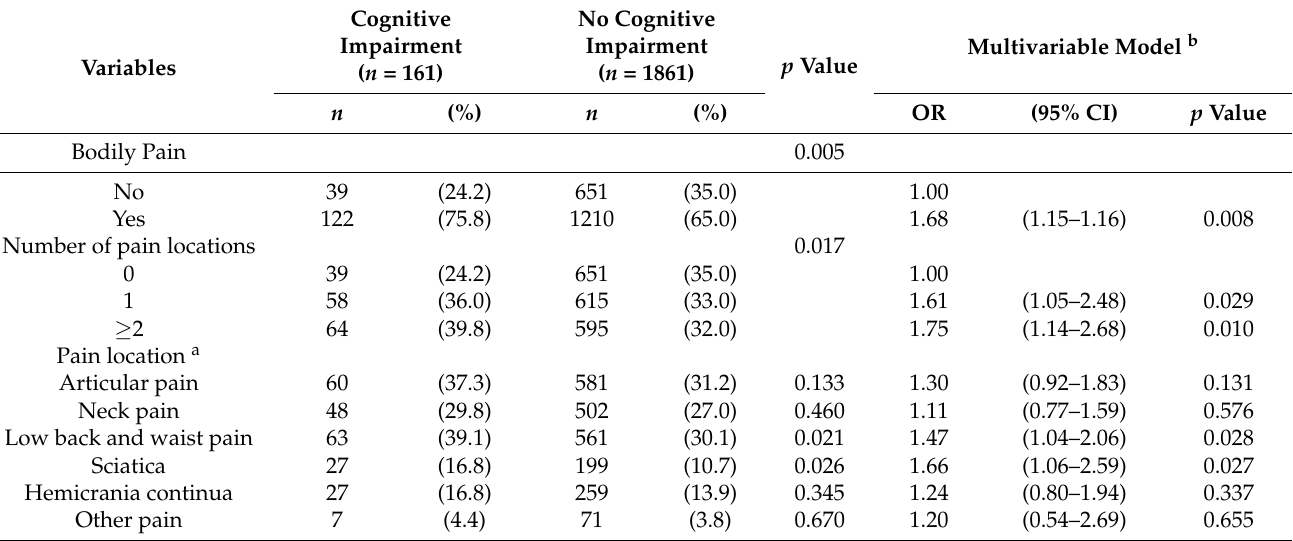
Table 2. Proportions and univariable and multivariable logistic regression analyses of bodily pain factors for cognitive impairment development among community-dwelling older